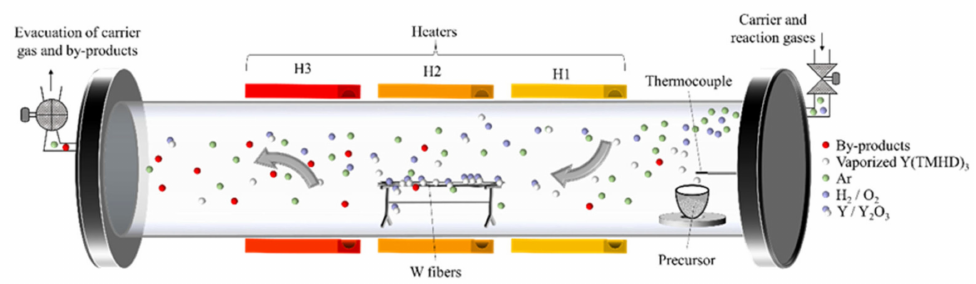
Figure 1. General schematic for the discontinuous MOCVD of Y/Y 2 O 3 on W f .